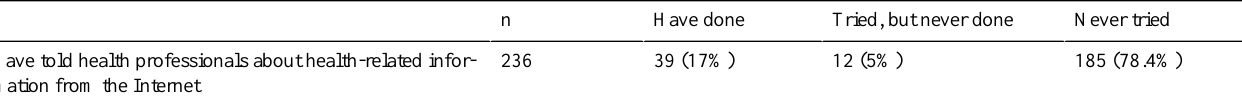
Table 8. Perceived effects of Internet use on health-related activities (experiences of telling health professionals about health-related information from the Internet) among Internet users